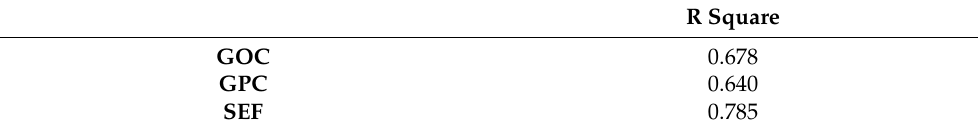
Table 5. R Square Values.